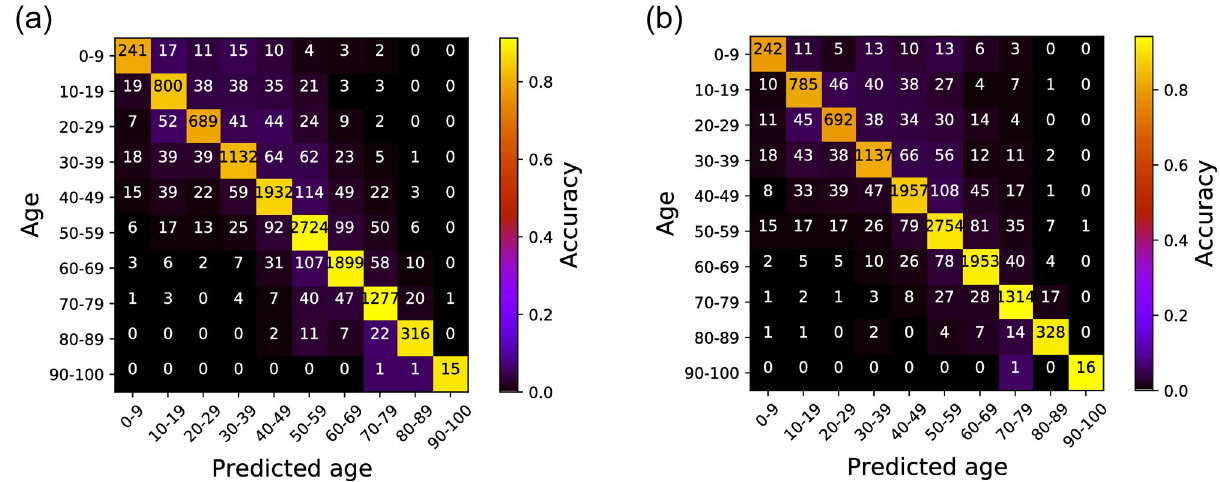
Fig 4. Confusion matrix for the age group prediction performance using PTA thresholds. The X-axis shows the predicted age group of the patient and the Y-axis shows the ground-truth. The numbers in the matrix present the number of prediction occurrences. An ideal confusion matrix would have bright colors (high occurrence counts) diagonally. (a) Left ear, (b) Right ear.